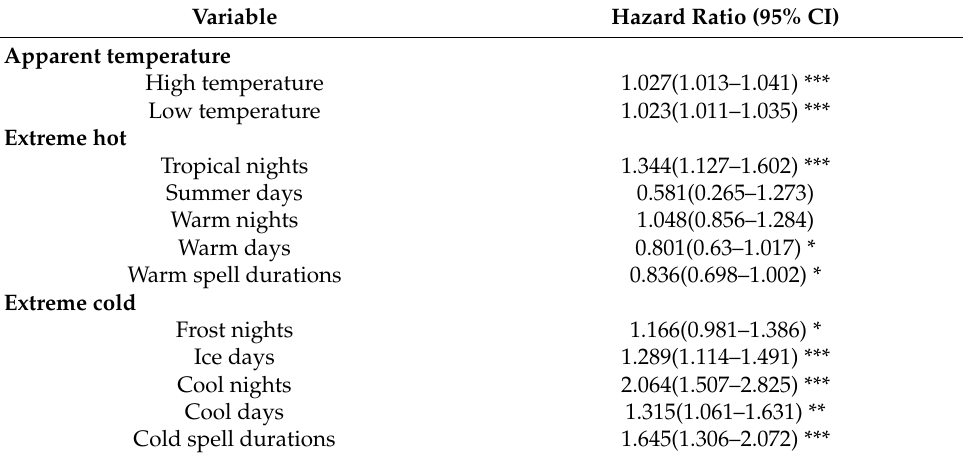
Table 2. Cox regression models of time to having depressive symptoms,